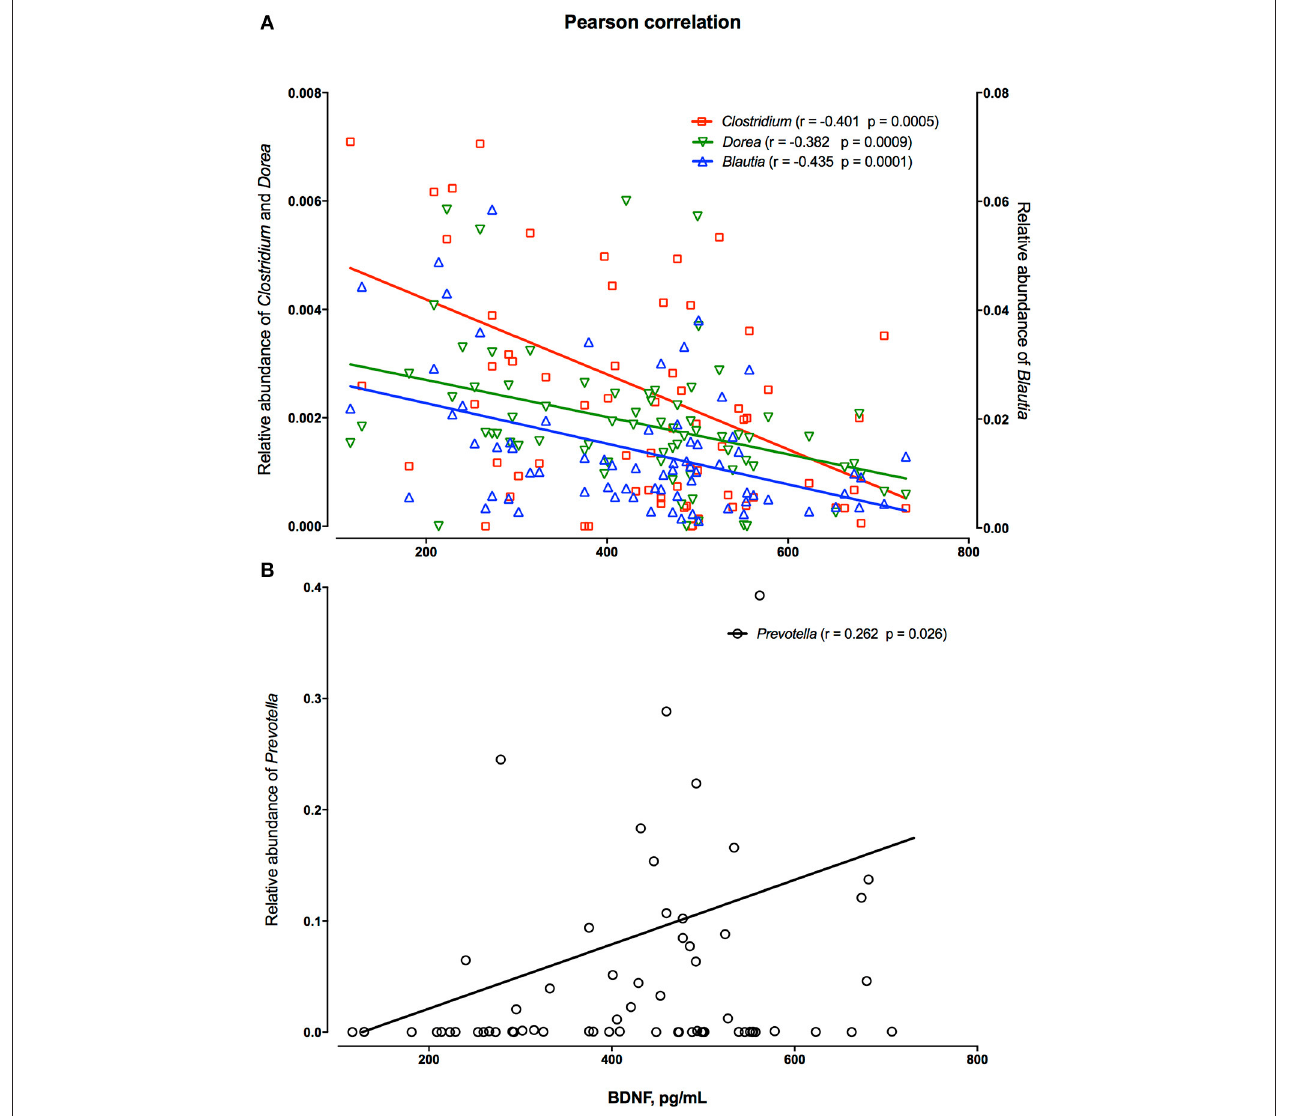
FIGURE 4 | Pearson correlation between relative abundance of fecal Clostridium , Dorea , Blautia (A) and Prevotella of individual persons irrespectively of the product consumption or priming period (B) and their blood levels of brain-derived neurotrophic factor